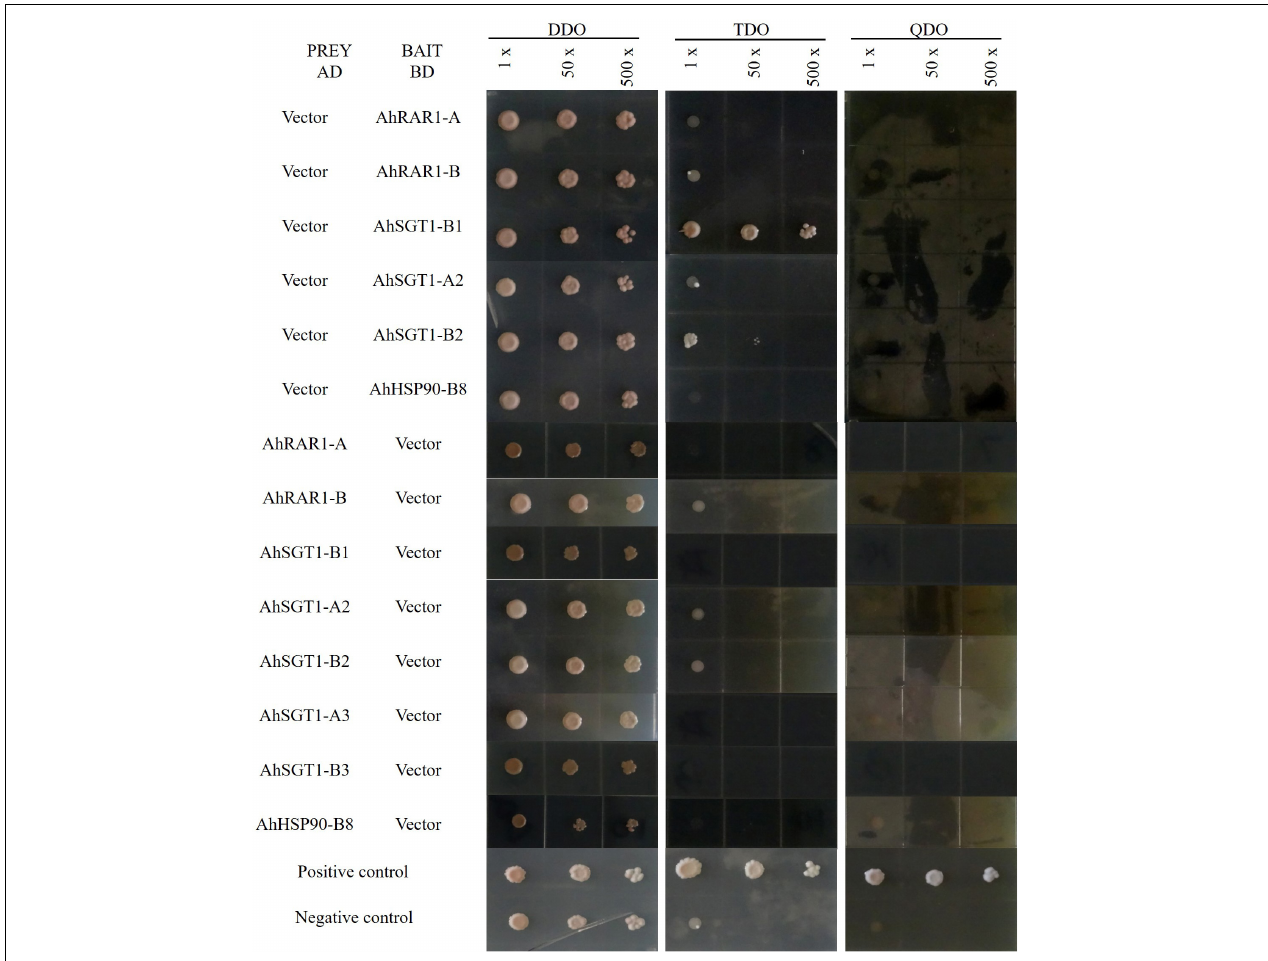
FIGURE 9 | Autoactivation test of HRS proteins. The successfully cotransformed yeast containing both AD and BD plasmids was collected from DDO medium and inoculated on TDO and QDO media with the original resuspension (1 × ), a 50-fold dilution (50 × ), or a 500-fold dilution (500 × ).